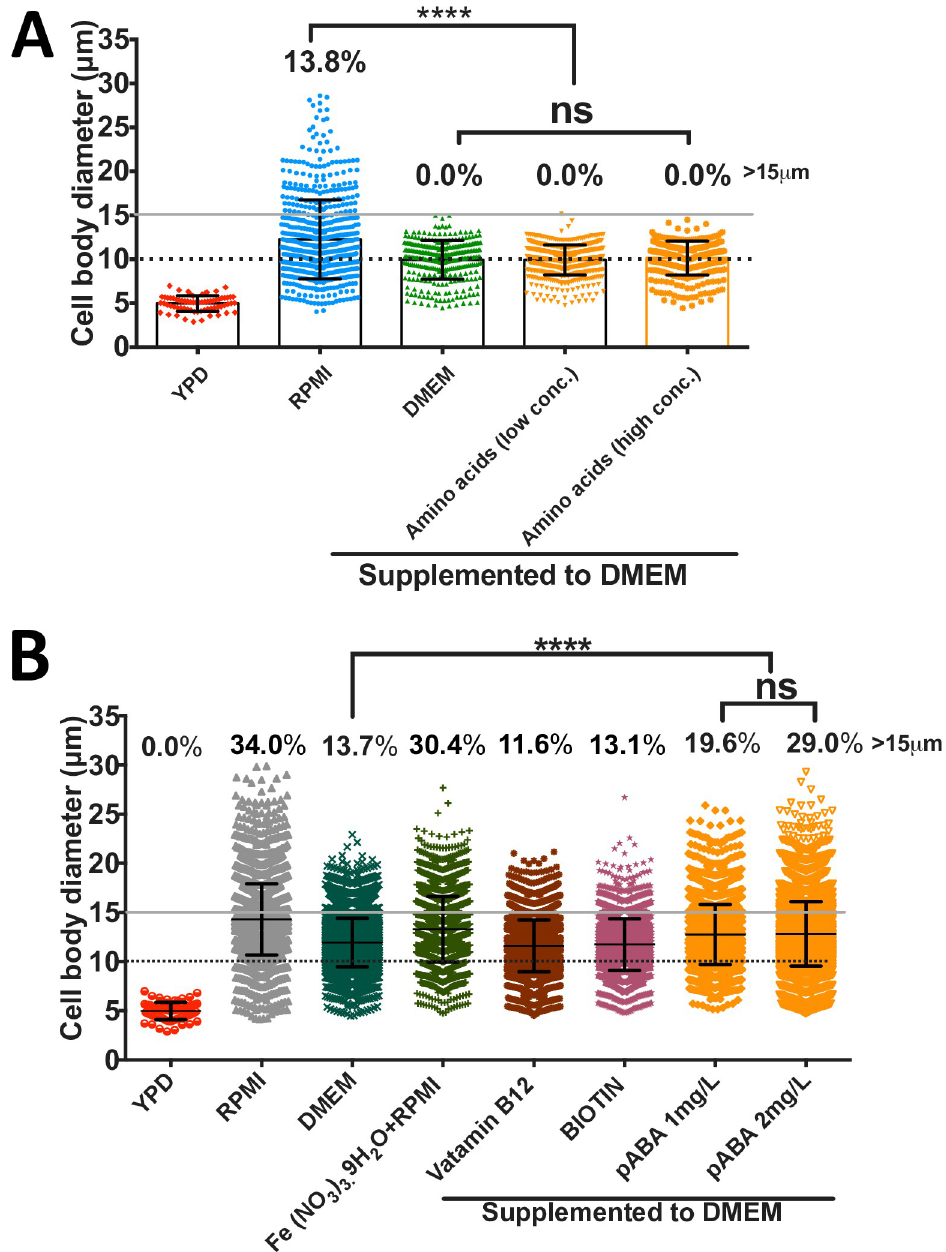
Fig 7. The effect of RPMI-specific compounds on R265 titan cell formation. A) RPMI-specific amino acids (L-Glutamic acid, L-Aspartic acid, L-Arginine, L-Glutathione, L-Asparagine and L-Proline) were added to DMEM either at the concentration used in RPMI (‘low conc.’) or two-fold higher (‘high conc.’) and tested for their capacity to trigger titan cell formation after 24 hr induction at 37˚C in 5% CO 2 . B) RPMI-specific compounds (Vitamin B12, Biotin, and para aminobenzoic acid (pABA)) were supplemented to DMEM at the levels present in RPMI and then evaluated for their capacity to induce titan cell formation after 3 days incubation at 37˚C in 5% CO 2 . The graphs are representation of 3 biological repeats and statistical significance was determined by Kruskal-Wallis test, where ���� = p < 0.0001.